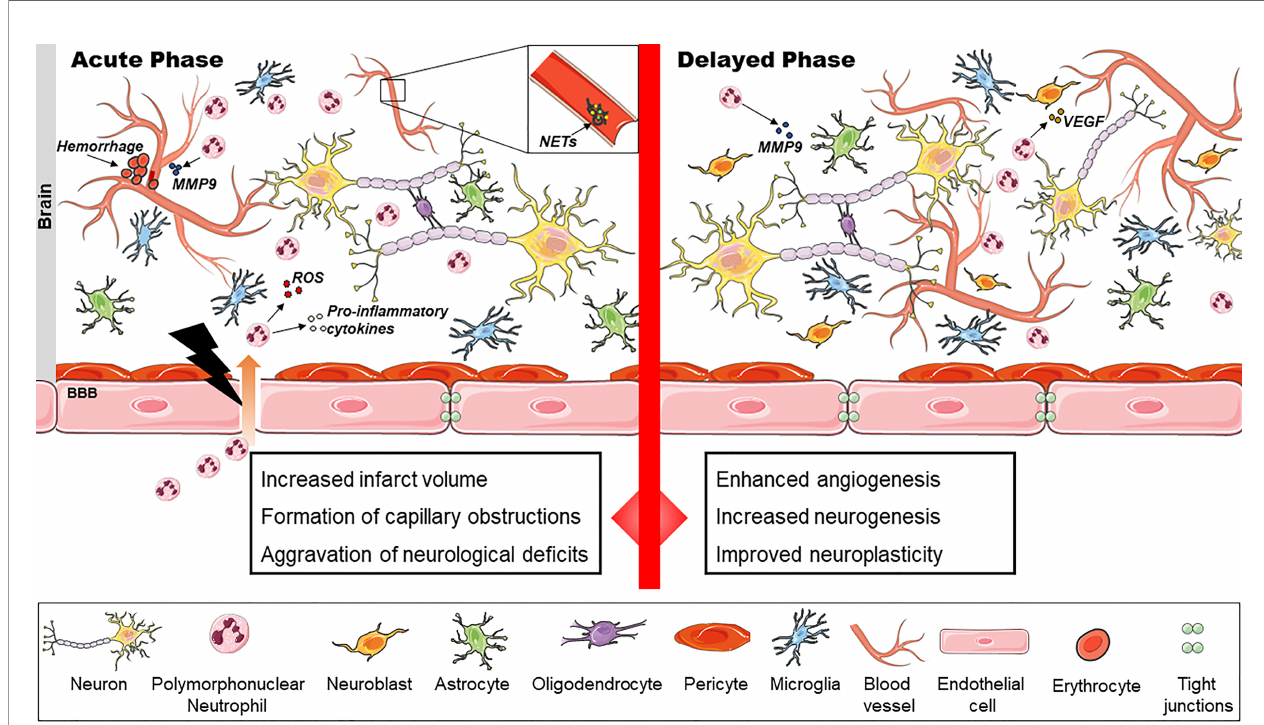
FIGURE 1 | The dual role of polymorphonuclear neutrophils (PMNs) in ischemic stroke. PMNs exacerbate stroke injury in the acute phase by release of reactive oxygen species (ROS) and in fl ammatory cytokines. Intracerebral hemorrhages may result. Neutrophil extracellular traps (NET) contribute to capillary reperfusion disturbances. In the delayed phase, PMNs enhance cerebral angiogenesis, neurogenesis and neuroplasticity presumably by VEGF release, extracellular matrix (ECM) degradation and